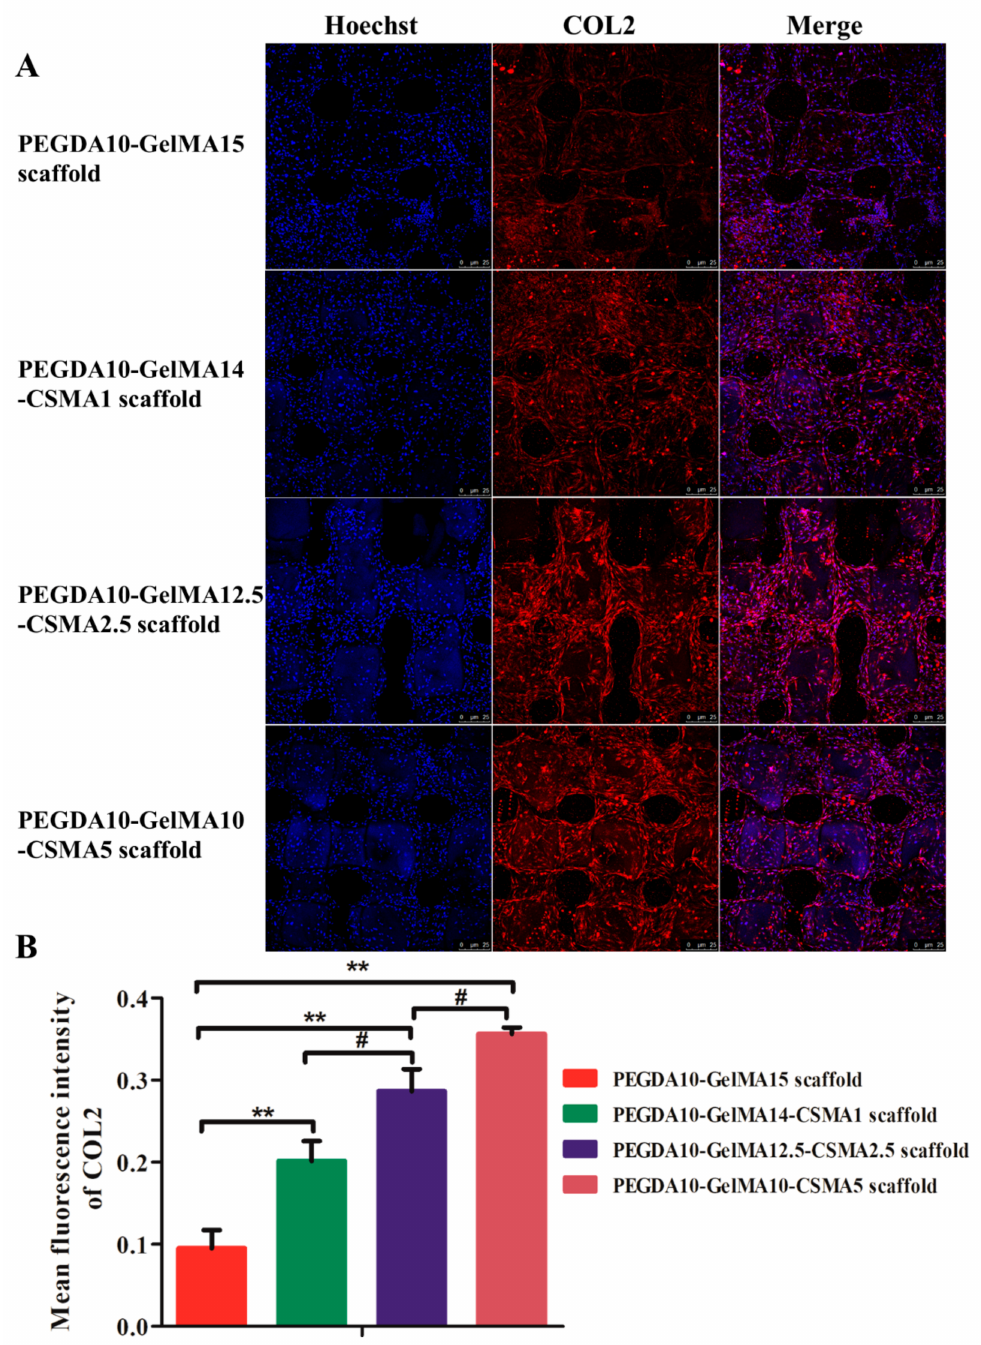
Figure 5. Immunofluorescent staining of COL2 on the scaffolds seeded with BMSCs. ( A ) Immunoflu- orescence staining images and ( B ) mean fluorescence intensity of COL2 secreted by BMSCs on four scaffolds on day 14. The nuclei are stained blue while the protein COL2 is stained red. The scale bar is 25 µ m ( n = 3; ** p < 0.01, # p <